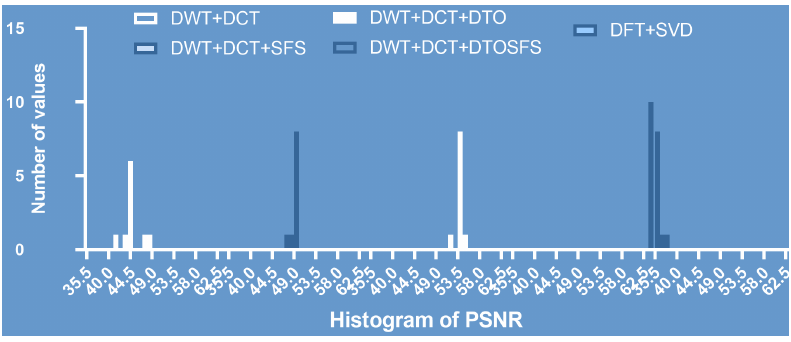
Figure 10. Histogram of the PSNR values achieved with the proposed approach.